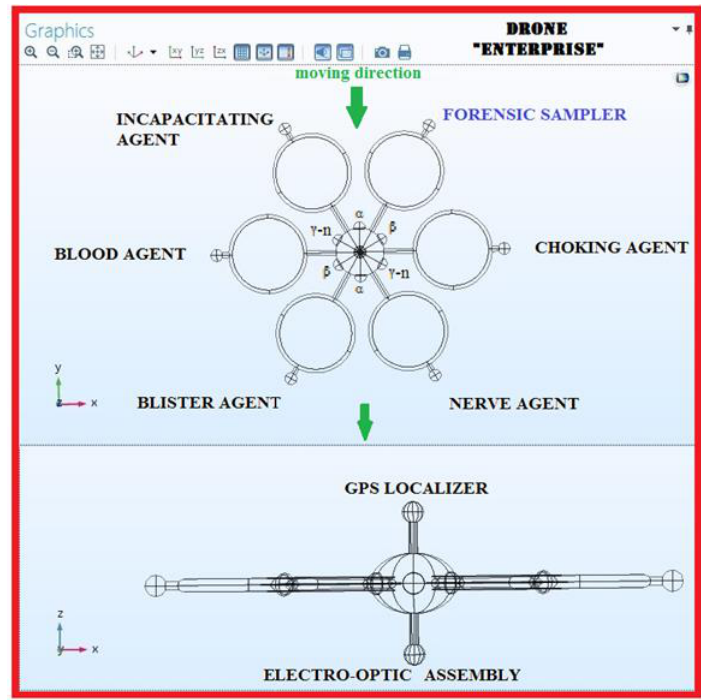
Figure 12. The “Enterprise” super detecting and identifying virtual drone design, showing all capabilities. Once Enterprise reaches the edge of a plume, it can be turned by 60° increments, while in hovering mode, to detect and identify many radioactive contamination, thanks to its sensors hosted at the maximum performance locations on the drone.